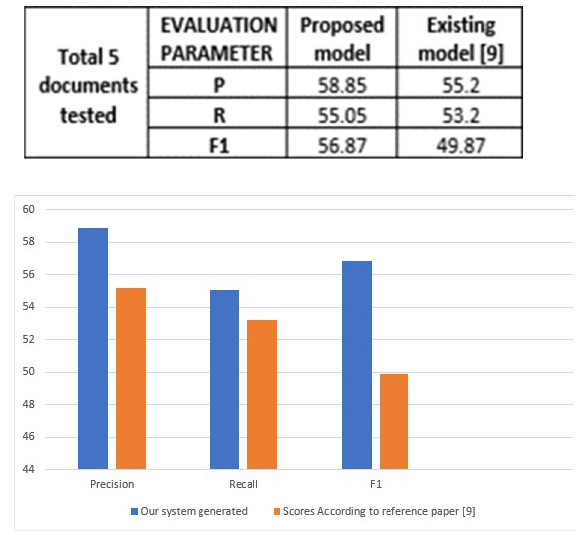
Fig. 5 Graphical comparison between results obtained by proposed model and previous